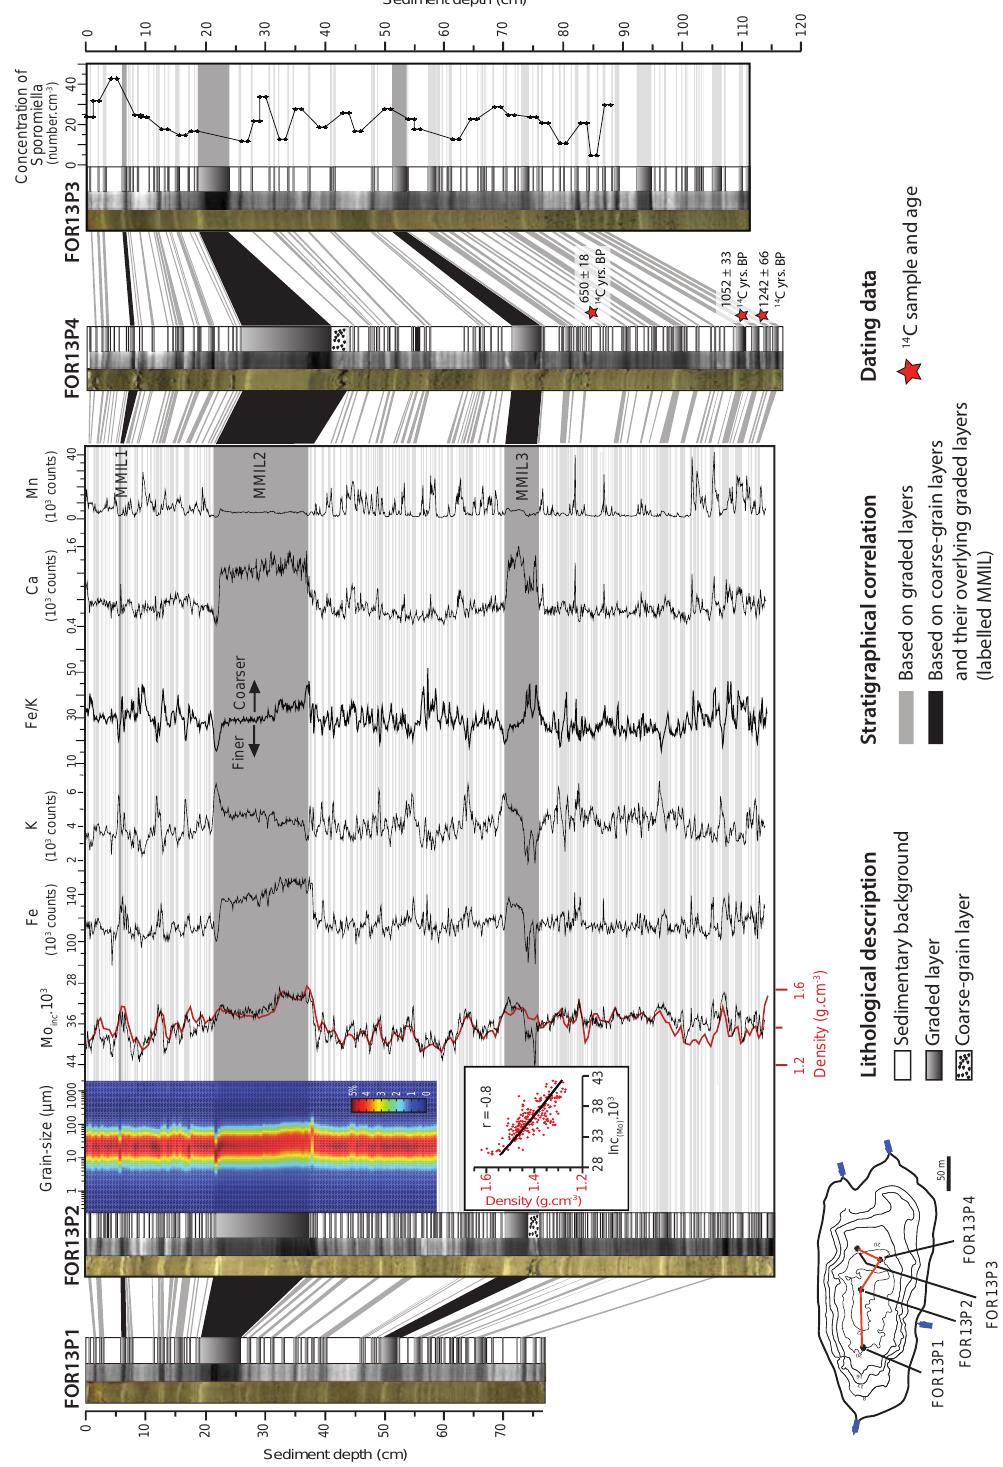
Figure 2. Lithological descriptions of cores and stratigraphic correlations based on sedimentary facies. For each core, a photo (left), an X-ray image (centre) and a stratigraphic log is shown (right). 14 C samples are indicated by red stars. Variability in grain-size distribution and geochemical elements (Fe, K, Ca and Mn) is shown for the core FOR13P2. Mo inc used as a high-resolution proxy of density is shown close to the density measurements performed by gamma-ray attenuation. Variability in Sporomiella concentration is shown for core FOR13P3.